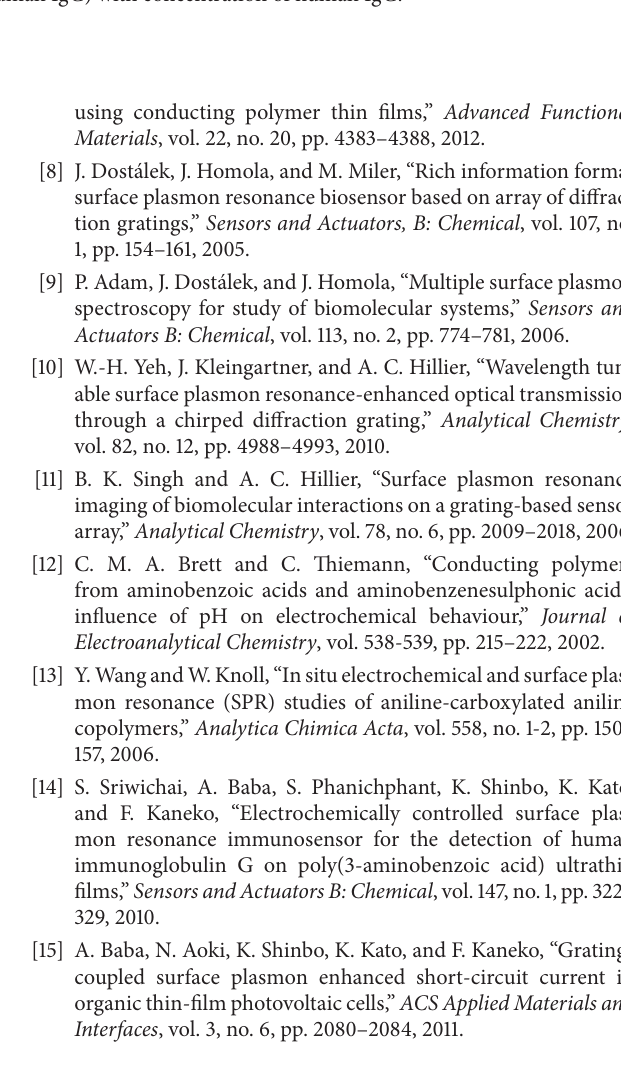
Figure 5: TSPRspectra of PABA film after binding process of anti-human IgG and human IgG on (a) BD-R and (b) DVD-R grating substrates. Insets show plots of the shift of TSPR intensity (after binding with human IgG) with concentration of human